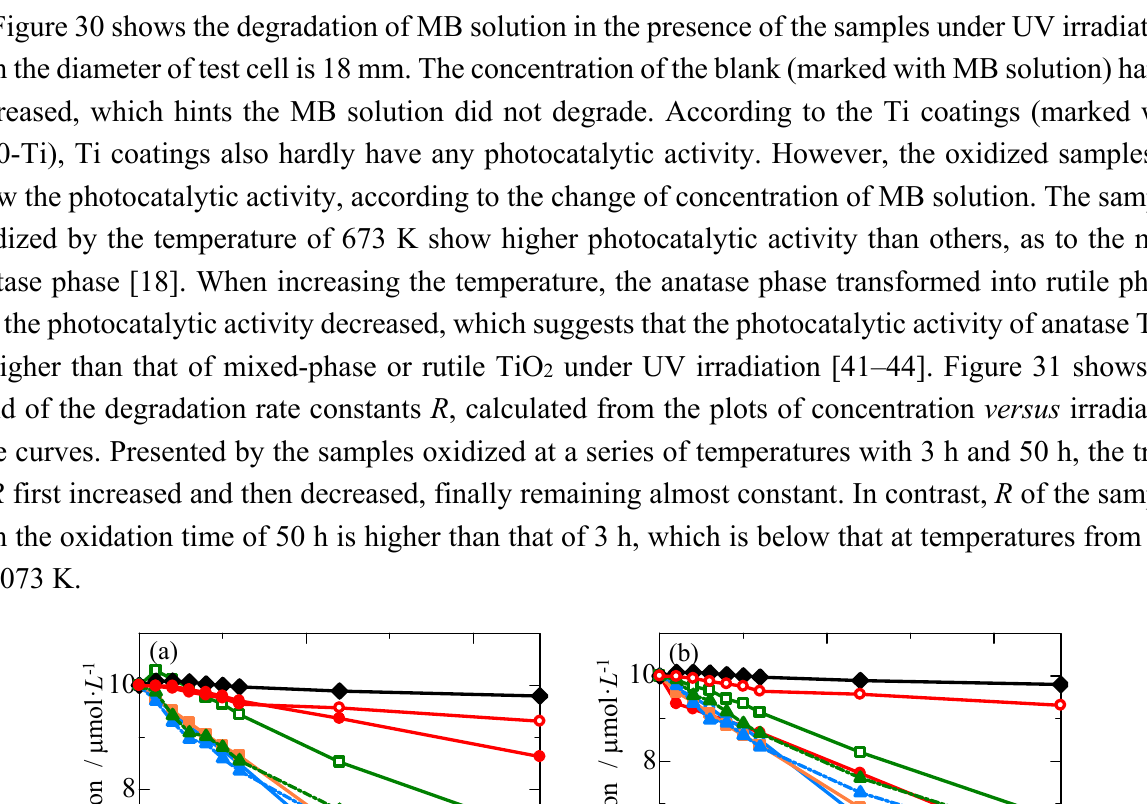
Figure 29. Relationship between oxidation time at 1073 K and thickness of TiO 2 coatings.